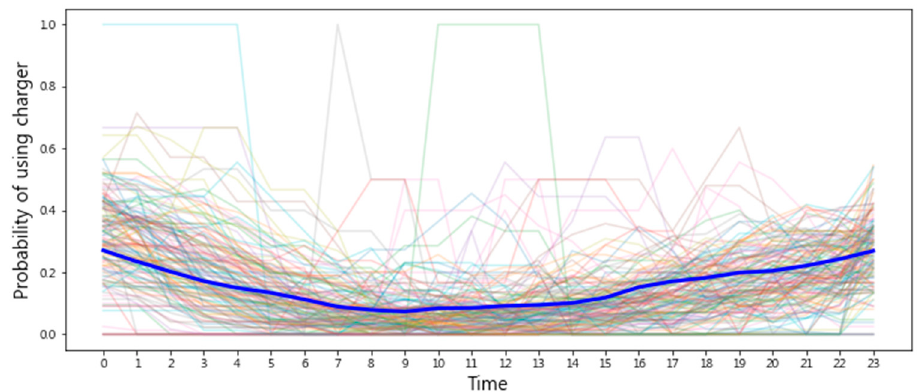
Figure 1. The estimated probability of the charge availability.